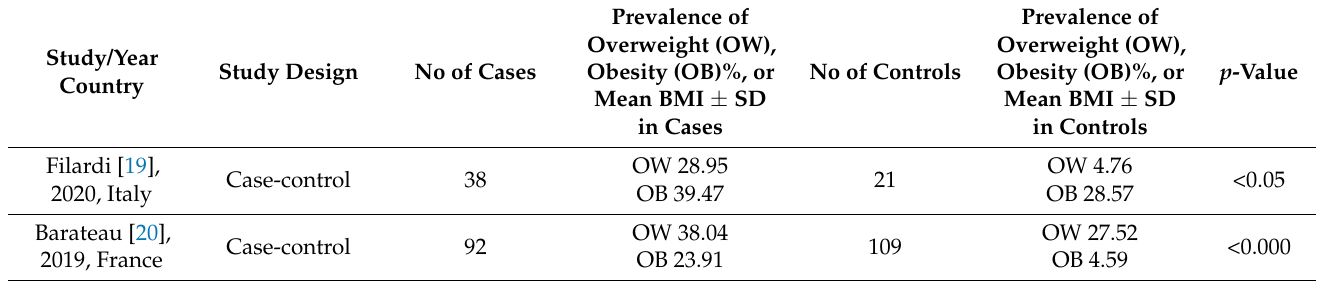
Table 1. A summary of the studies that assessed the prevalence of overweight and obesity in patients with